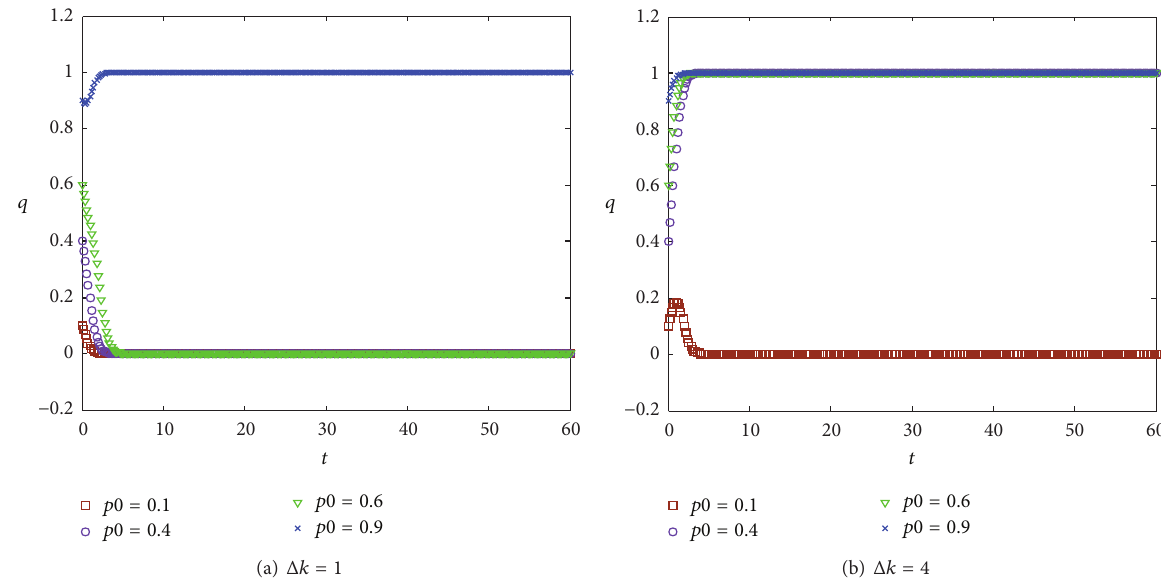
Figure 8: The influence of the news media’s disclosure mechanism on the cooperation